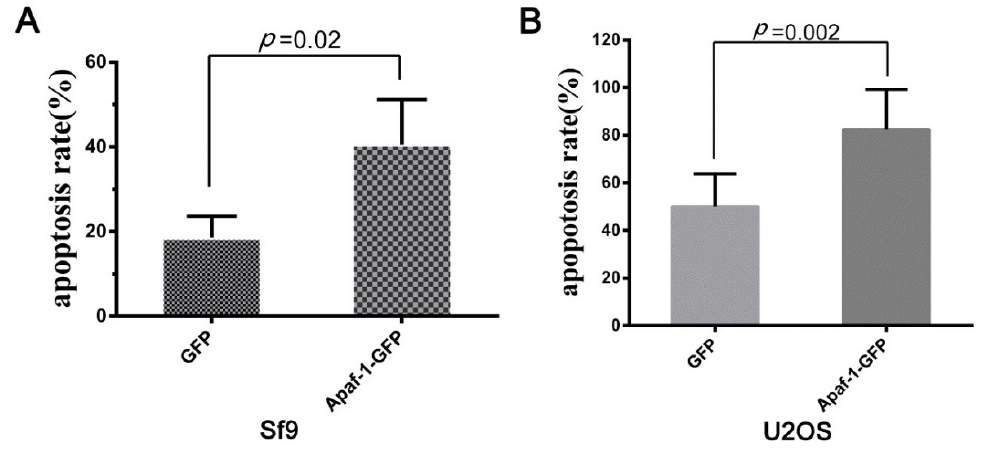
Figure 6. Act-D-induced apoptosis of insect cells (Sf9, ( A )) and mammalian cells (U2OS, ( B )) when Sl-Apaf-1 was overex- pressed. Sl-Apaf-1 was